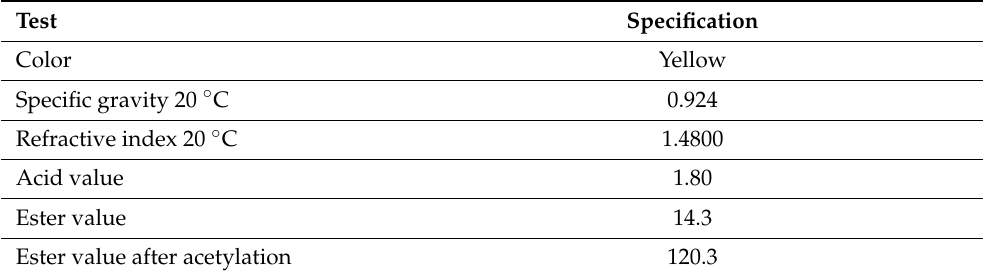
Table 2. Physio-chemical characteristics of essential oil of Hedychium spicatum .